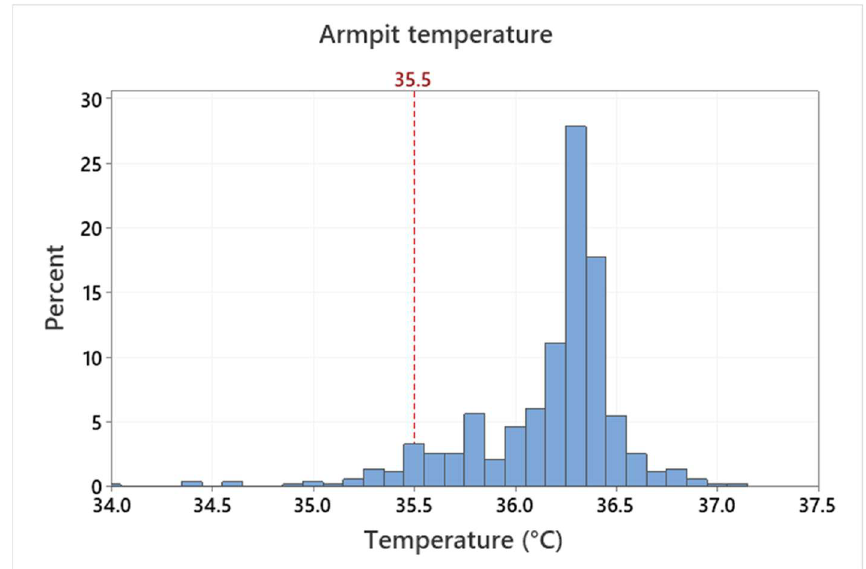
Figure 6. Histogram distribution of the armpit temperature measurement.